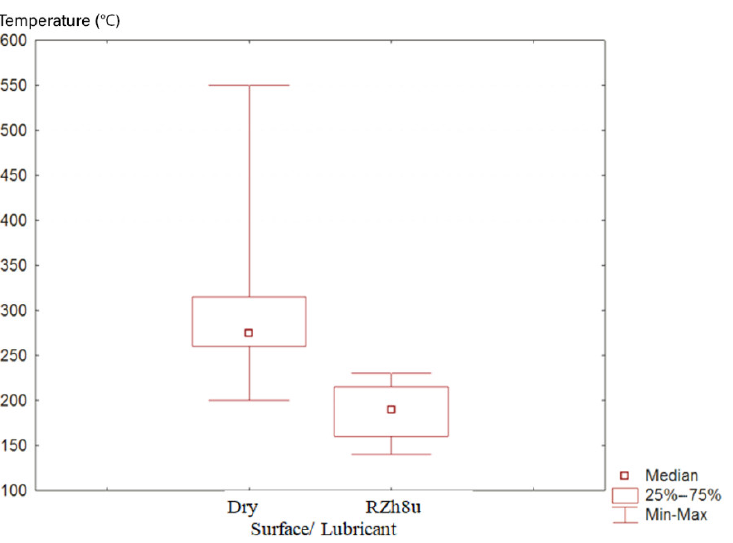
Figure 4. Influence of lubrication on temperature with varying other factors. Each experiment in Table 4 was repeated 5 times for the first six samples and for 3 times for the last six samples.